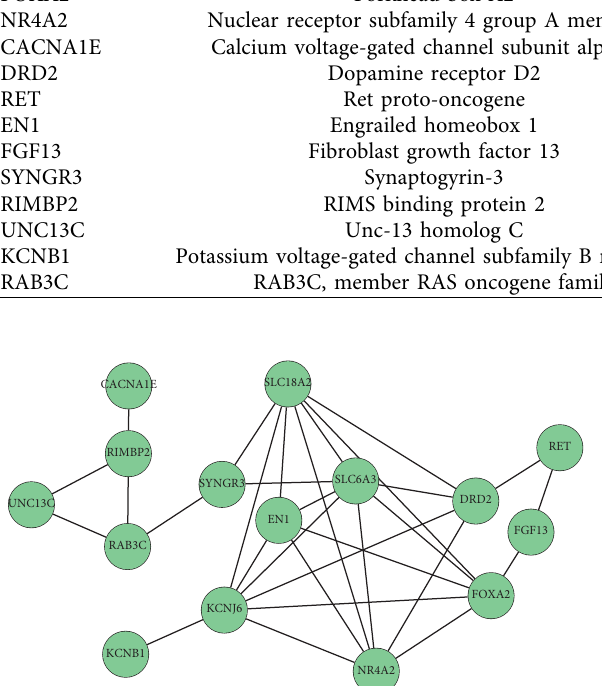
Figure 5: Interaction network of 15 hub genes. Te green color represents the downregulated genes screened based on fold change ≤ − 1.0 and P value <